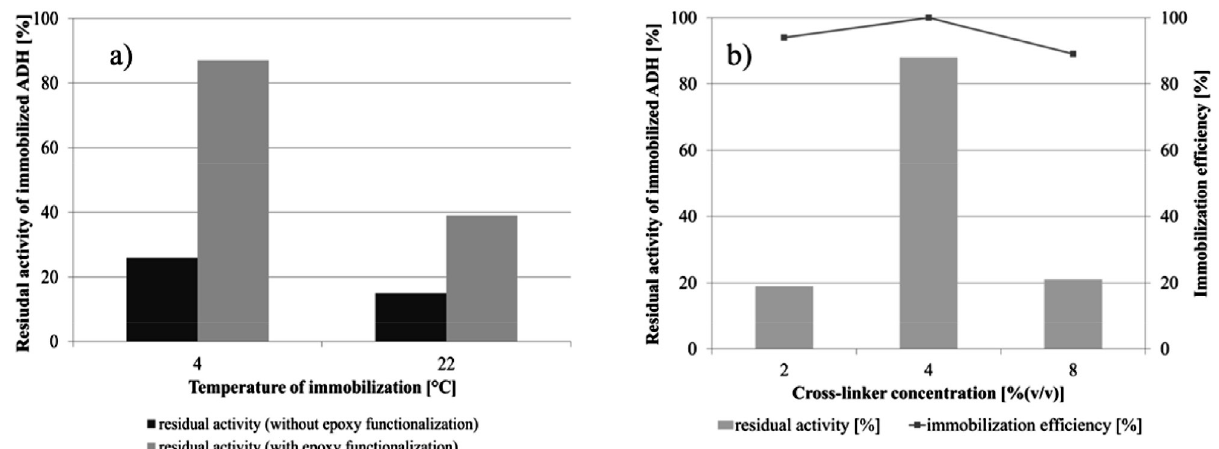
Figure 2. Residual activities of ADH immobilized onto CMD-MNPs, while investigating temperature of immobilization with and without epoxy functionalization (a) and cross-linker concentration (b).